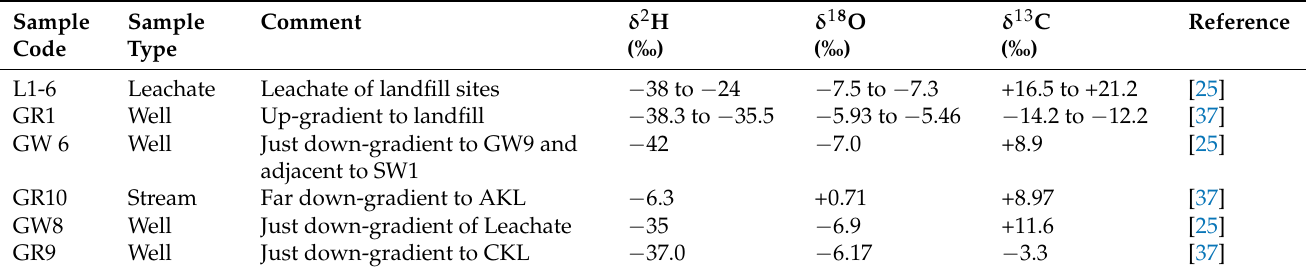
Table 4. Isotope data of hand-dug wells, stream, and leachate